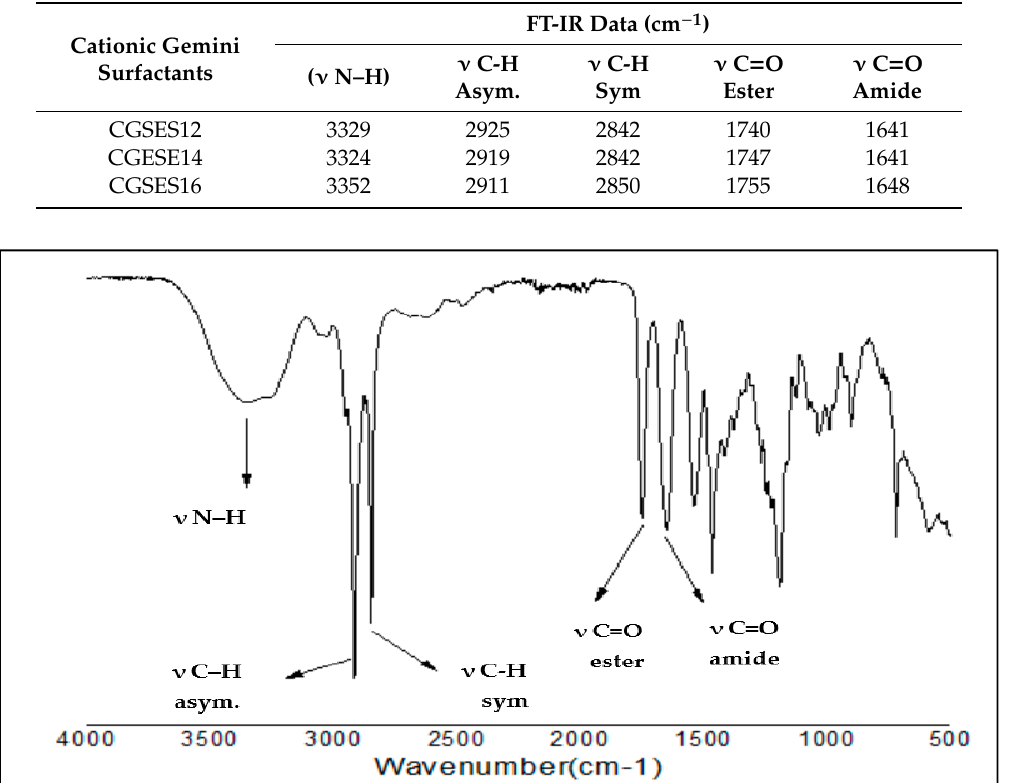
Table 1. FT-IR data of cationic gemini surfactant.